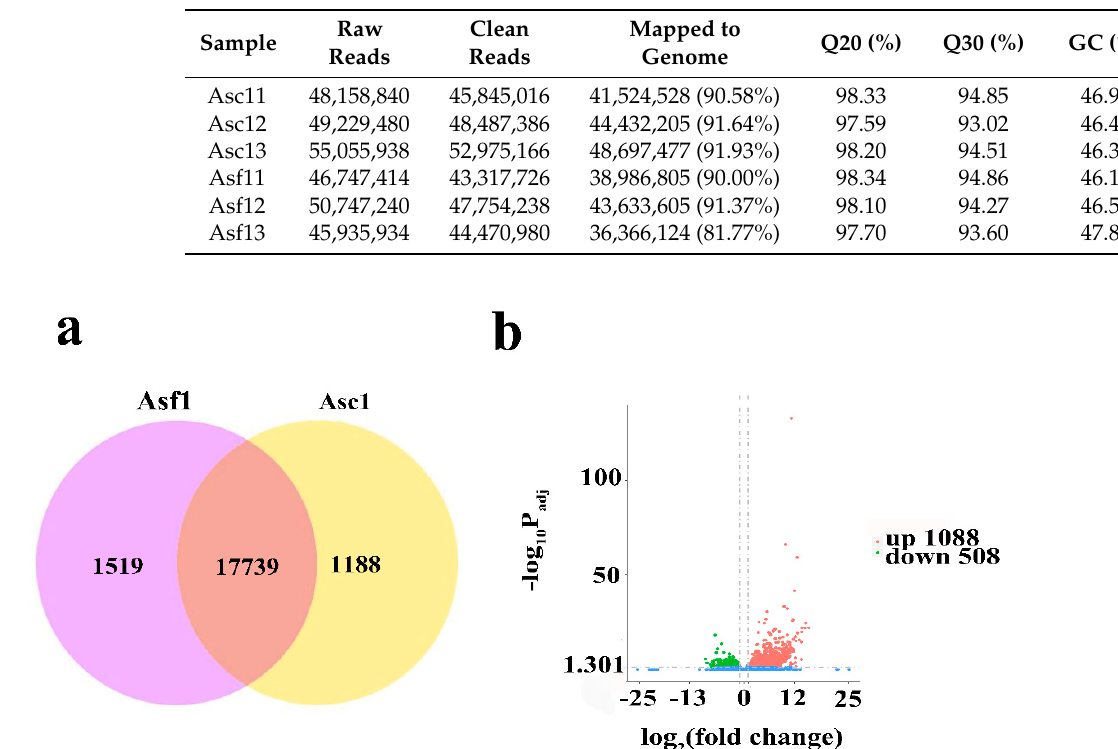
Table 1. Summary of RAN-seq data of A. sinensis after mechanical wounding.